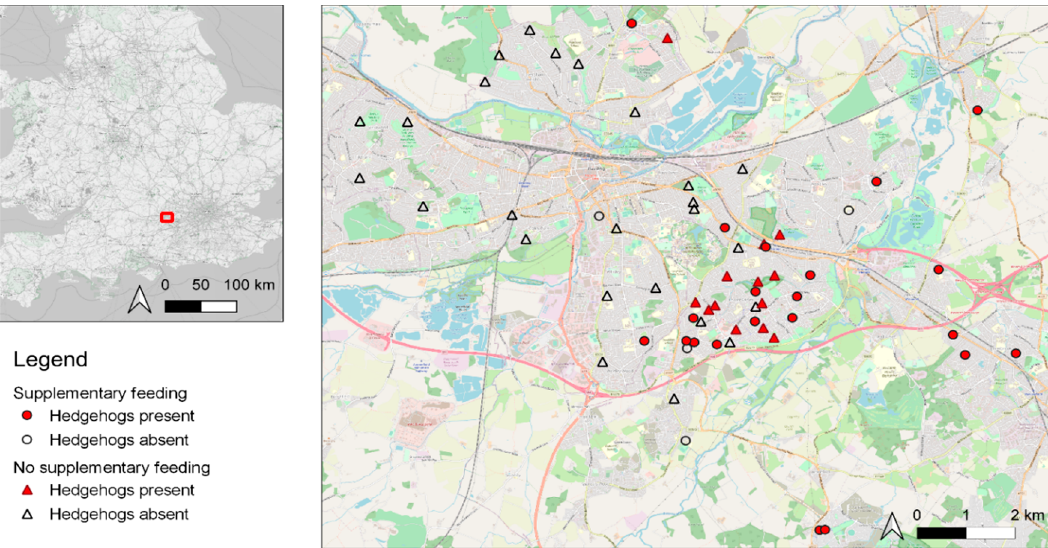
Figure 1. The locations of gardens (n = 63) in Reading and surrounding areas surveyed for hedgehogs between November 2017 and April 2018 inclusive. Circles denote gardens where hedgehogs were fed by householders prior to the study; diamonds denote gardens where hedgehogs were not fed prior to the study; filled and open symbols denote gardens where hedgehogs were and were not detected at any point during the current study, respectively.